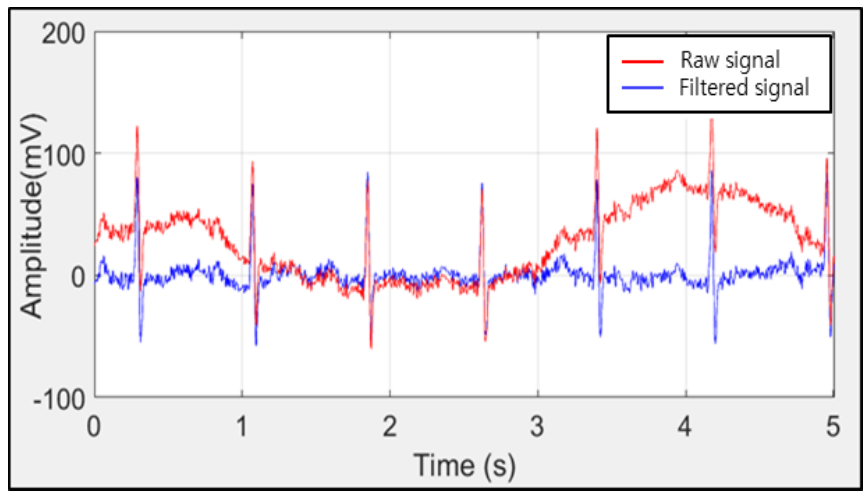
Figure 3. Digital filter was designed in MATLAB and applied to the ECG signal. Butterworth high- pass and low-pass filters were designed (5−250 Hz) , and a band-stop filter was used to reduce the noise at 60 Hz.